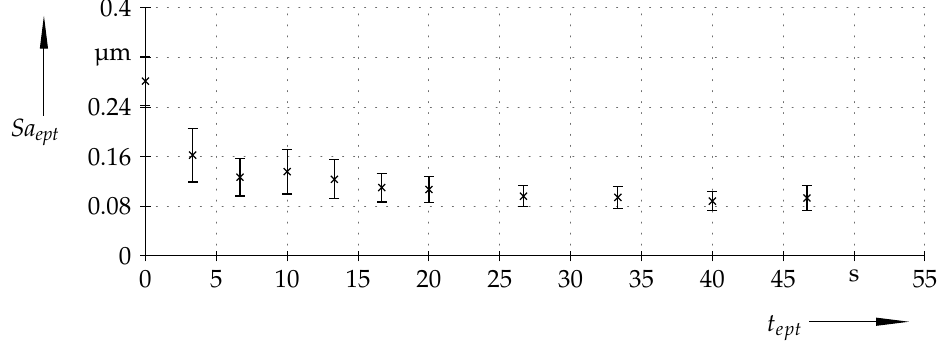
Figure 6. Mean average surface roughness Sa ept of the weld seam dependent from t ept . The initial average surface roughness Sa 0 is located at the position t ept =